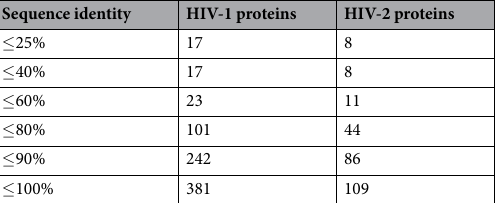
Table 4. The distributions of sequence identity for HIV-1 proteins and HIV-2